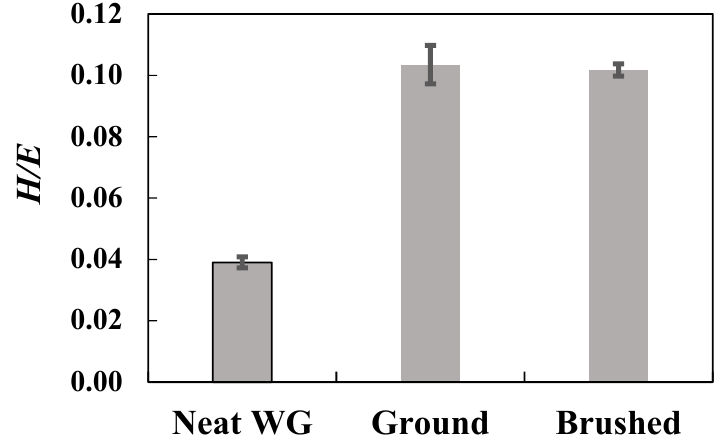
Figure 4. Wear resistance measured top-down.